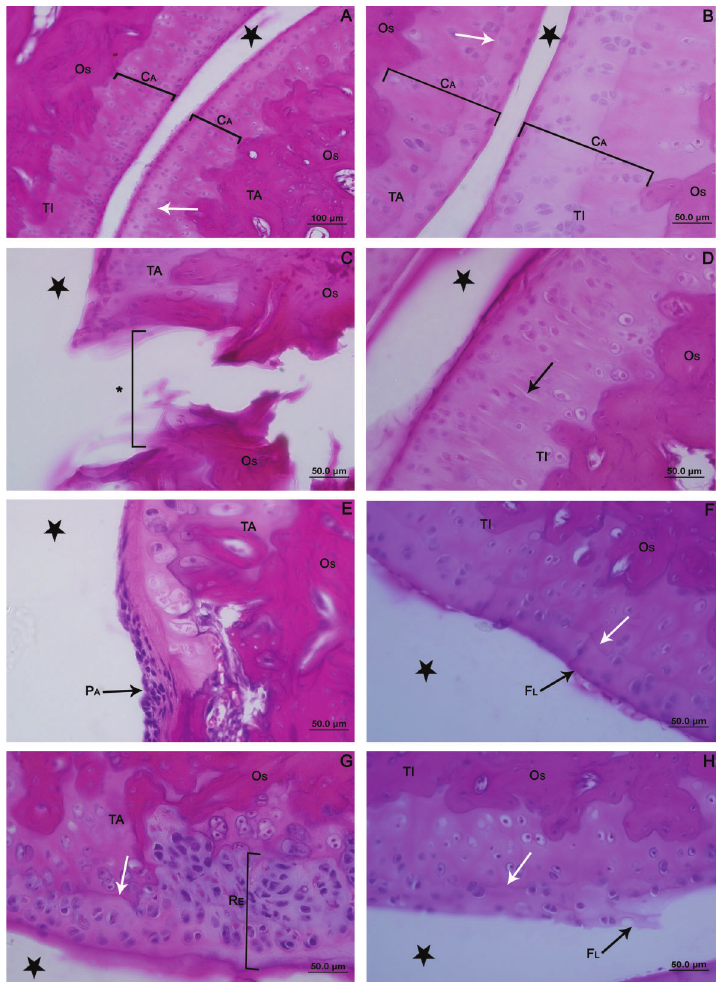
Figure 2. Photomicrographs of the articular cartilage of the ankle joint of the control contra- lateral hindlimb of Wistar rats ( A and B ); G1 ( C and D ); G2 ( E and F ); G3 ( G and H ). Sagittal section, hematoxylinand eosin staining. A , Panoramicview showing the articular cartilage (CA). B , Details of cellular organization. C , Loss of cartilage (asterisk) with exposed subchondral bone (OS). D , Cracks (black arrow). E , Pannus formation (PA). F , Presence of flocculation on the surface of cartilage (FL). G , Recovery of articular cartilage with the presence of clones (RE). H , Flocculation on the surface. Articular cavity (star), tidemark (white arrow), talus bone (TA) and tibia (TI). G1: immobilized; G2: remobilized freely for 14 days; G3: remobilized byswimmingand jumpingin water for 14